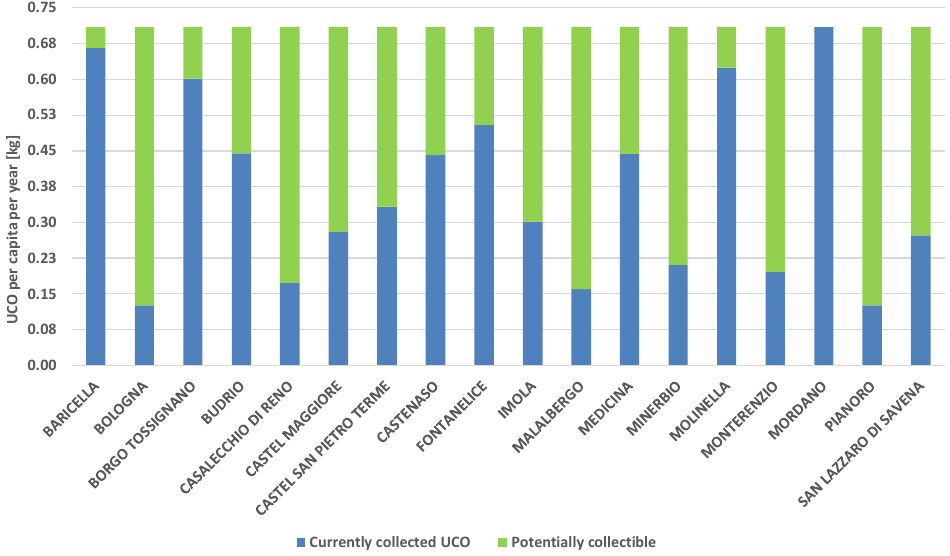
Figure 7. Collected and potentially collectible UCO per capita in the 2013–2014 biennium.